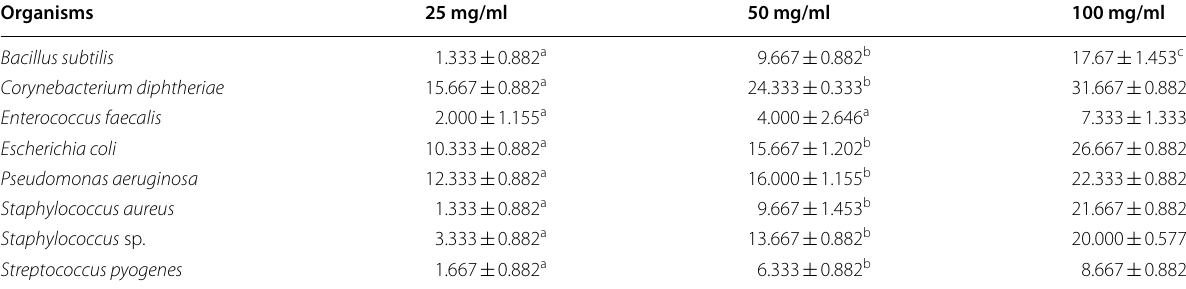
significantly different at p < 0.05 =